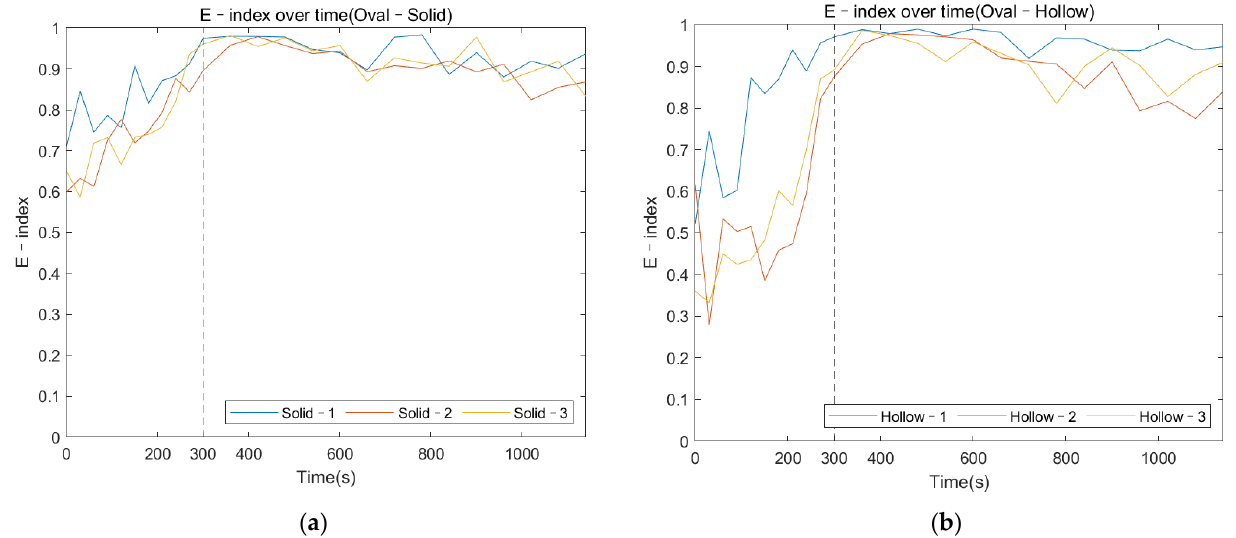
Figure 15. Variation of E–index at selected frequencies as the cure time increased for the oval implants under ( a ) solid and ( b ) hollow conditions. Table 3. Difference (relative to 0 s for each condition) for oval–shaped implants.